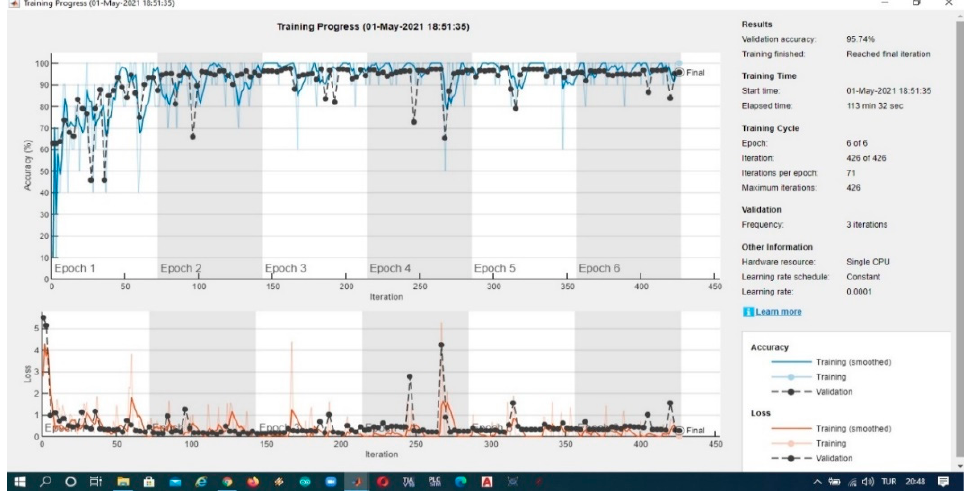
Figure 12. AlexNet training progress.